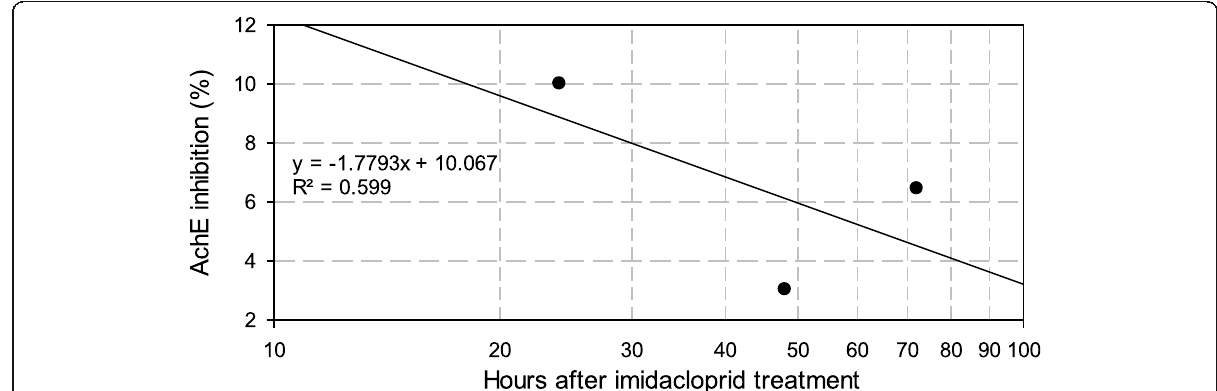
Fig. 3 Inhibition of AChE activity in Bactrocer zonata pupae treated with